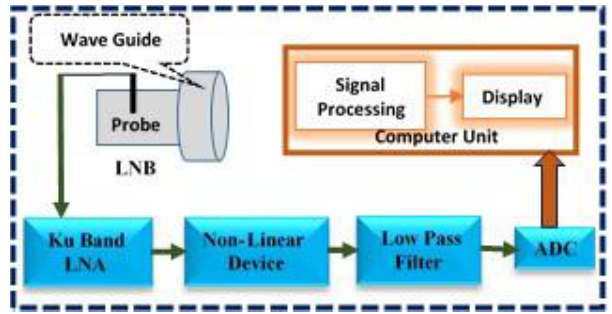
Figure 5. FSR receiver block diagram to receive direct DVB-S signal and signal scattered by the drone.